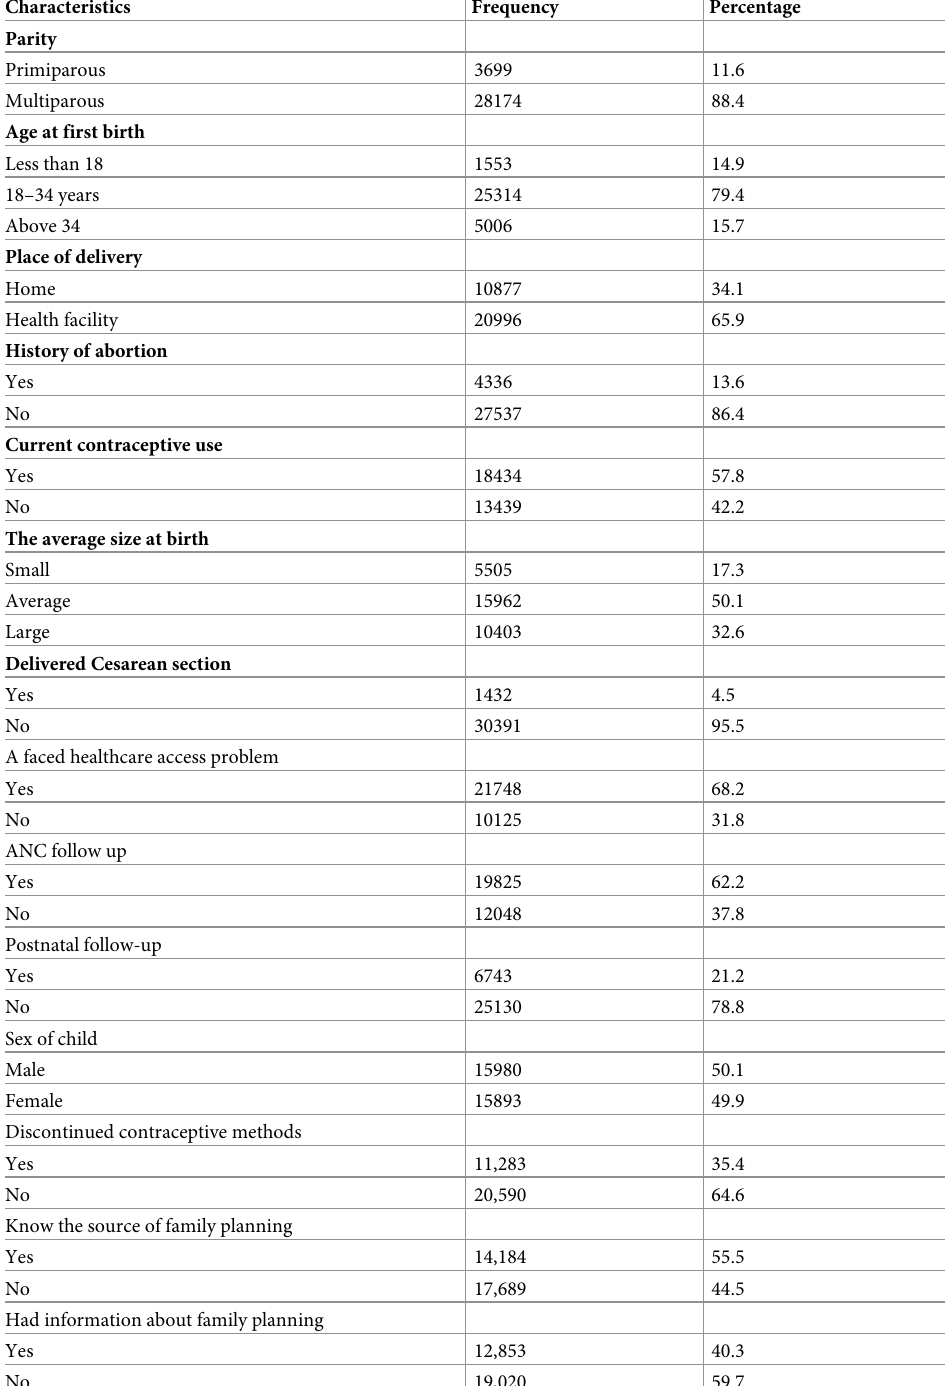
Table 2. Reproductive characteristics of child bearing women in East Africa